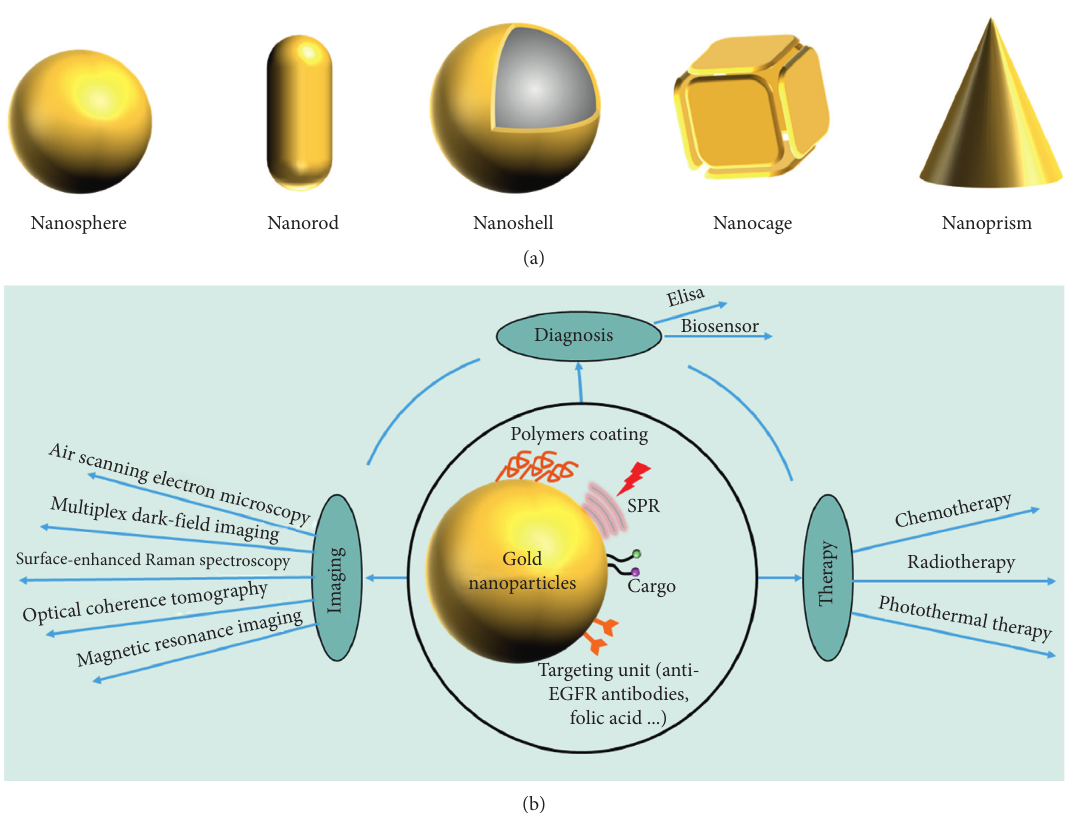
Figure 4: (a) The geometries of gold NPs. (b) Diagnosis and therapy of gold NPs.